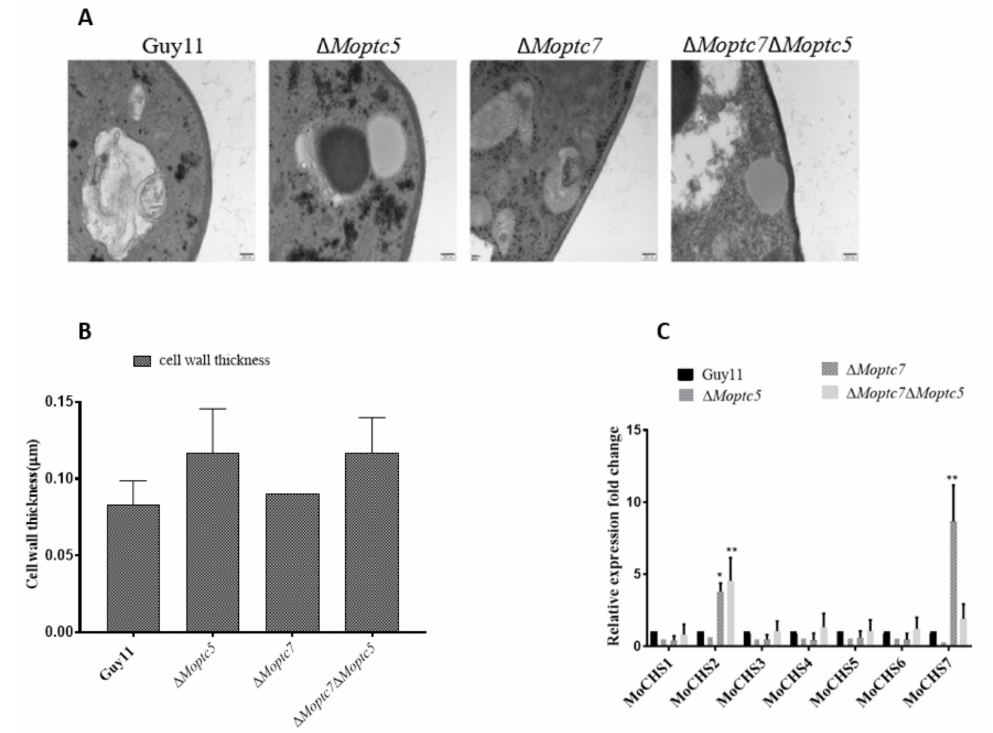
Figure 6. Deletion of MoPTC5 and MoPTC7 does not affect cell wall thickness. ( A ) Transverse sections of hyphae from Guy11, ∆ Moptc5 , ∆ Moptc7 and ∆ Moptc5 ∆ Moptc7 strains following transmission electron microscopy. ( B ) Graphs indicating differences in hyphal cell wall thickness between the mutants and Guy11. ( C ) The transcript levels of chitin encoding genes using actin gene as internal control. Three replicates were involved. Error bars represent standard deviations while asterisks show significant differences at different p -values (* p < 0.1; ** p < 0.01). The data were analyzed by one-way ANOVA using Tukey’s multiple-comparison